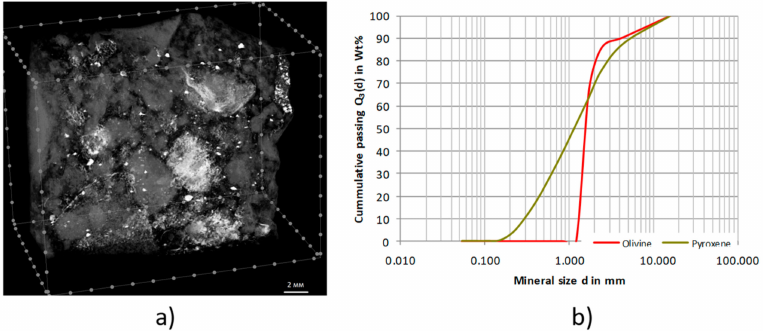
Figure 16. ( a ) Olivine and pyroxene grains in the volume of kimberlite and ( b ) their distribution according to the maximum